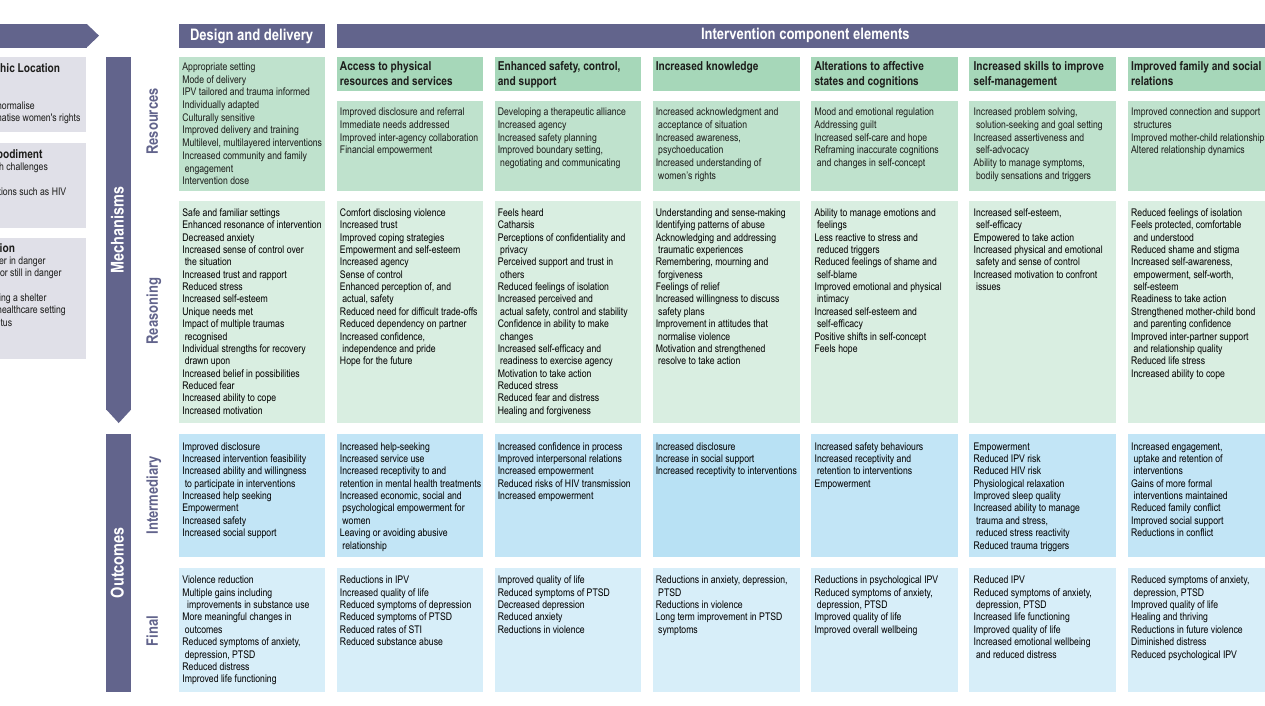
Fig 2. Final version of the conceptual model, mapping intervention components, outcomes, and